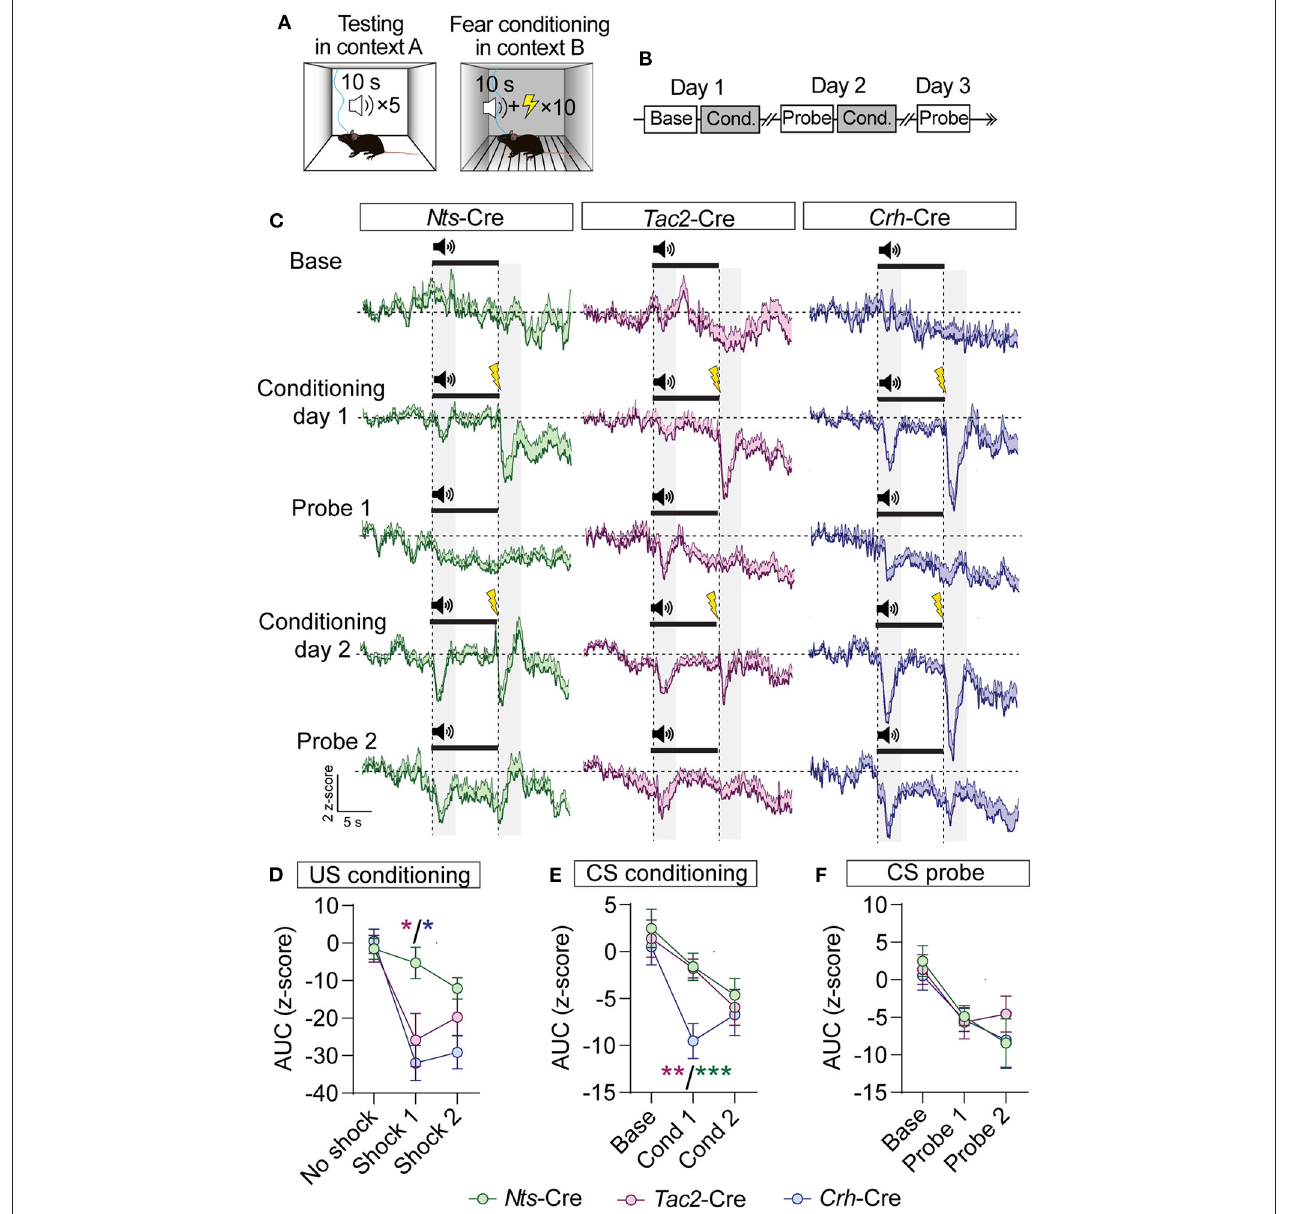
FIGURE 6 | GCaMP imaging of BNST → VTA axon terminals during fear conditioning in Nts-, Tac2-, and Crh -Cre mice. (A,B) Schematic of fear conditioning paradigm. Mice received baseline and probe sessions (cue delivery only) in context A, and conditioning sessions (cue + shock) in context B. (C) Average z-score ( + SEM) of the 1 F/F of the GCaMP signal aligned to the cue onset for all trials from all mice. (D–F) Area under the curve of the z-score for the 3s period following shock delivery (D) , following the onset of the CS during conditioning sessions (E) , or following the onset of the CS during probe sessions (F) [ n = 5 Nts -Cre, 6 Tac2 -Cre, and 5 Crh -Cre mice, 2-way RM ANOVA US Conditioning Interaction F (4,26) = 3.637, P = 0.0175, CS Conditioning Effect of Cre line F (2,13) = 4.716, P = 0.0288, Effect of Session F (1.3,16.89) = 11.90, P = 0.0017, CS Probe Effect of Session F (1.624,21.12) = 11.87, P = 0.0007, Tukey’s multiple comparisons * P < 0.05, ** P < 0.01, *** P < 0.001]. Data are presented as mean ± SEM.